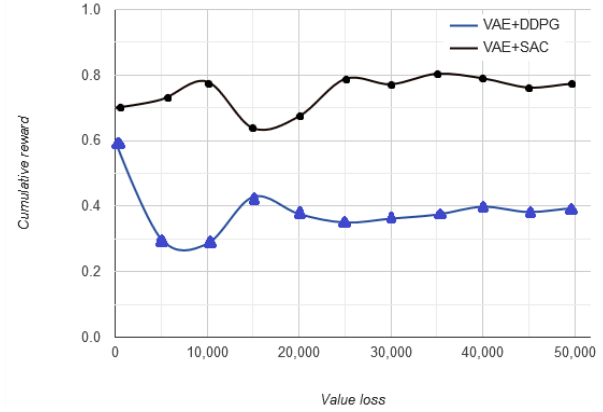
Figure 10. Cumulative reward vs. no. of timeframes.